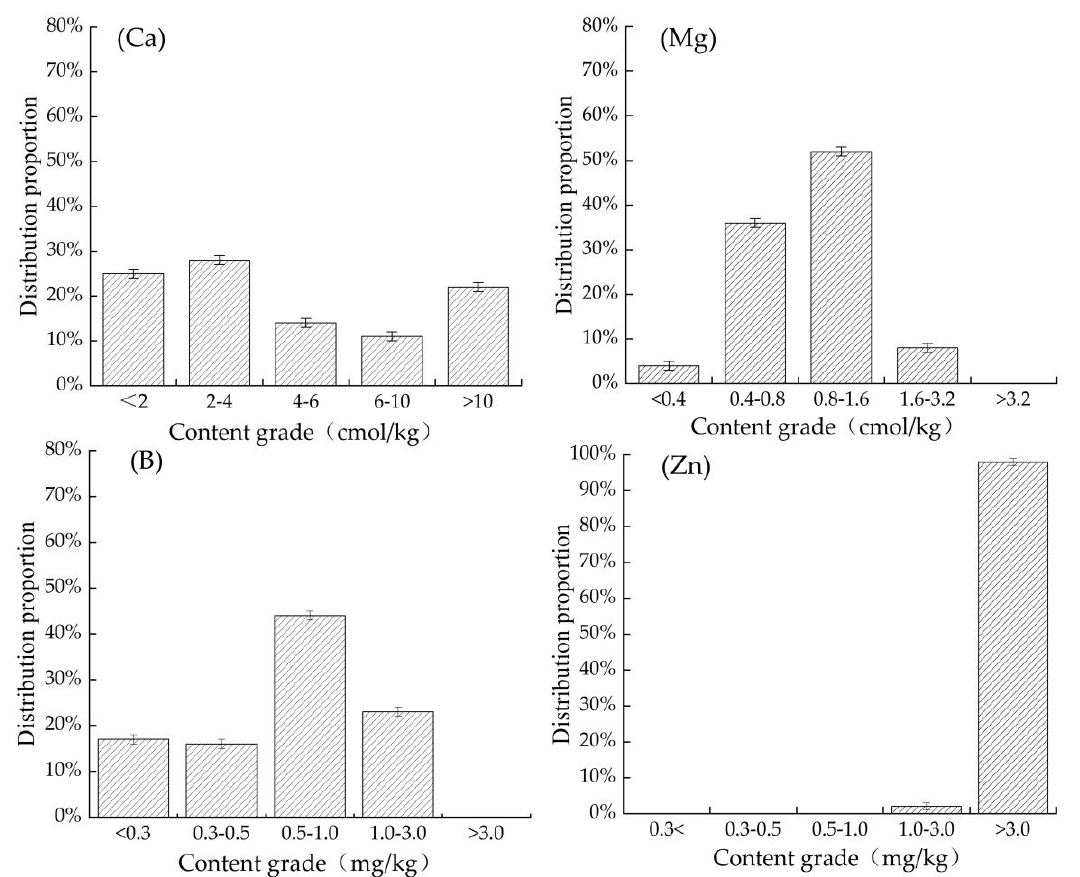
Figure 3. Distribution of exchangeable Ca, exchangeable Mg, available B and available Zn in tobacco 192 growing soil 193